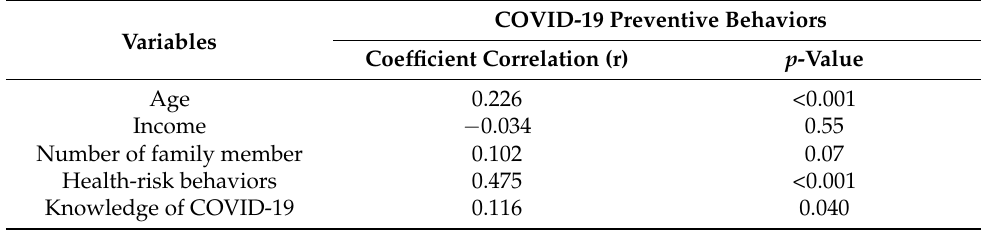
Table 3. Factors correlated with COVID-19 preventive